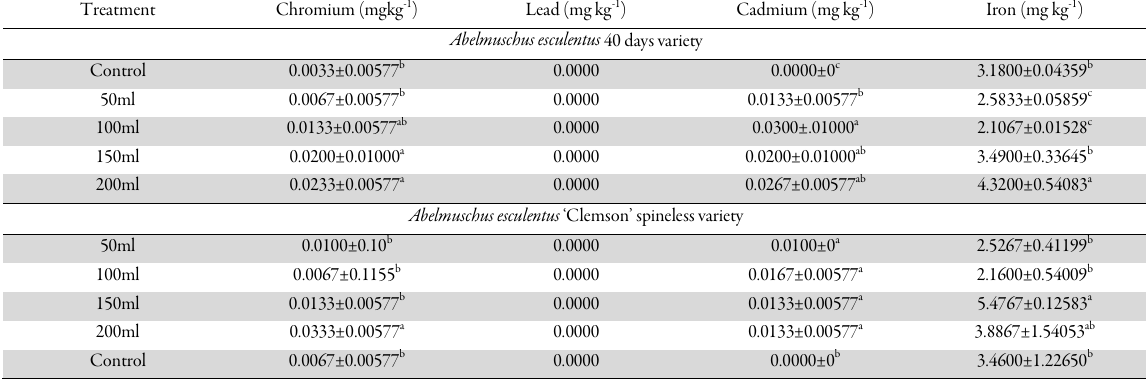
Table 13. Heavy metal contents of plants as influenced by the different concentrations of spent engine